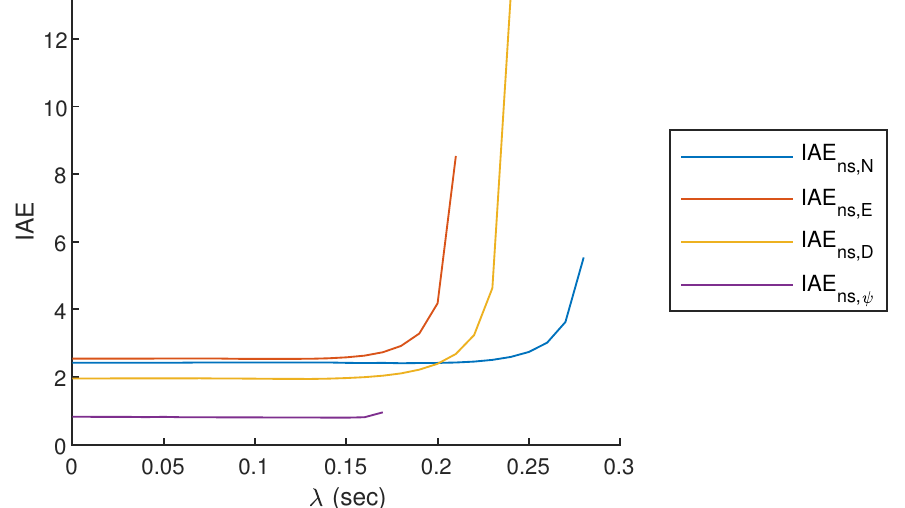
Figure 10. Integrated absolute error for various time delays for near-structure operation.